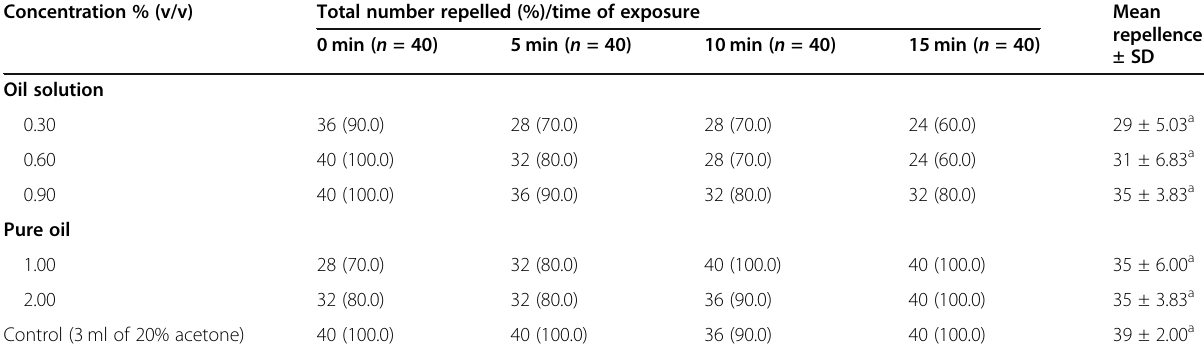
Table 1 Repellent effect of oil solution and pure oil of J. curcas on P. americana Concentration % (v/v) Total number repelled (%)/time of exposure